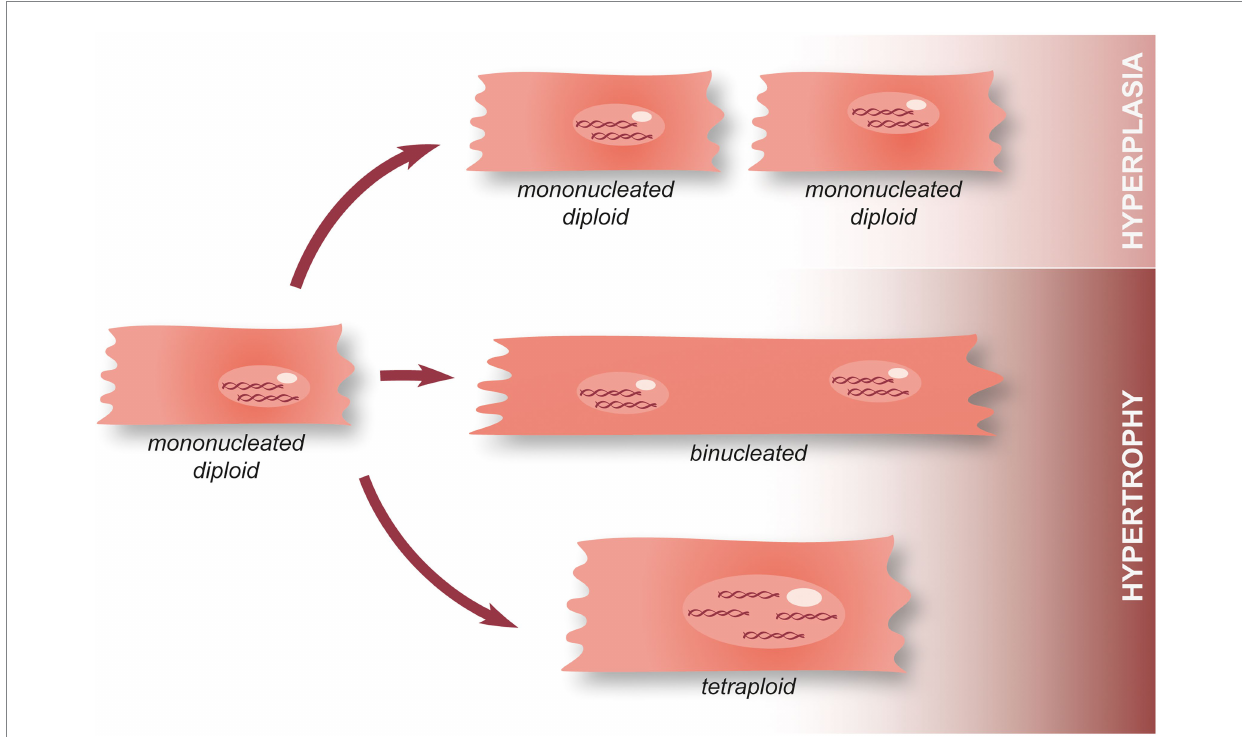
FIGURE 4 Hypertrophy and hyperplasia in cardiomyocytes. During the first postnatal week, mammalian cardiomyocytes switch from hyperplasia to physiological hypertrophic growth. Following this, a minority of mononucleated diploid cardiomyocytes remain present in the adult heart and can either undergo cell division associated with the annual turnover (hyperplasia), perform acytokinetic mitosis leading to the formation of a binucleated cardiomyocyte, or endoreplication making tetraploid cardiomyocyte. Once they become tetraploid or plurinucleated, cardiomyocytes lose their ability to perform